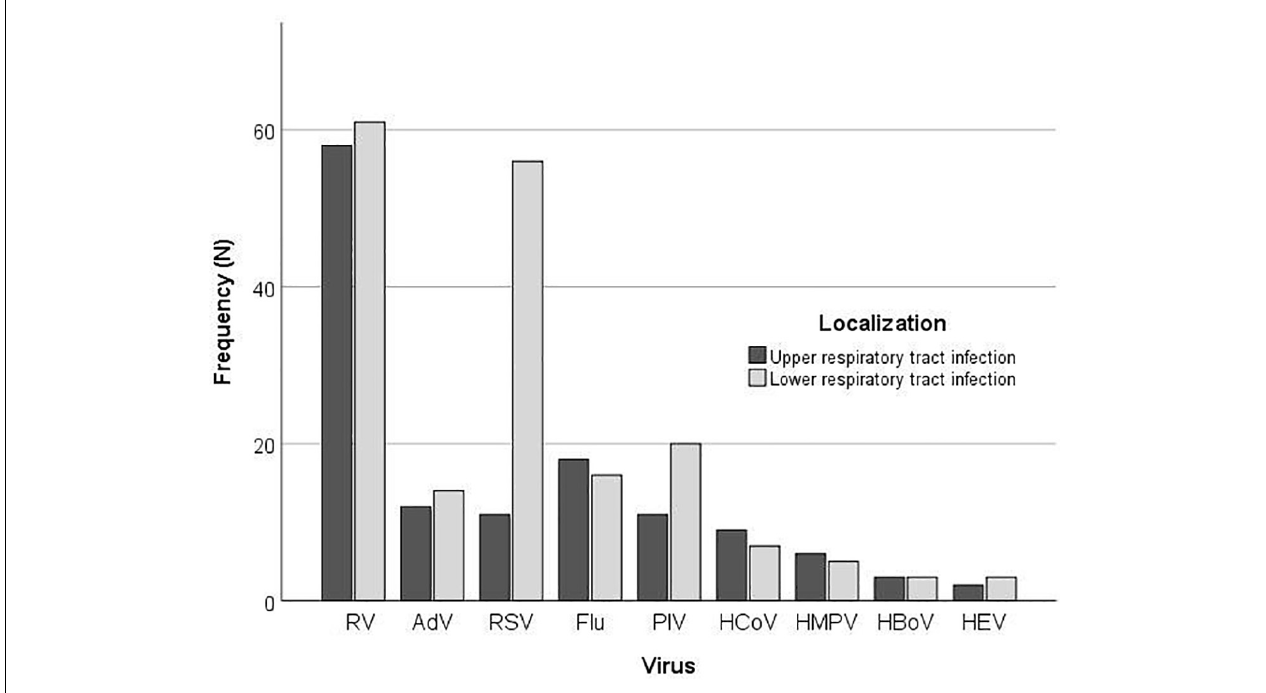
FIGURE 2 | Frequency of virus detection by multiplex PCR according to the localization of infection.